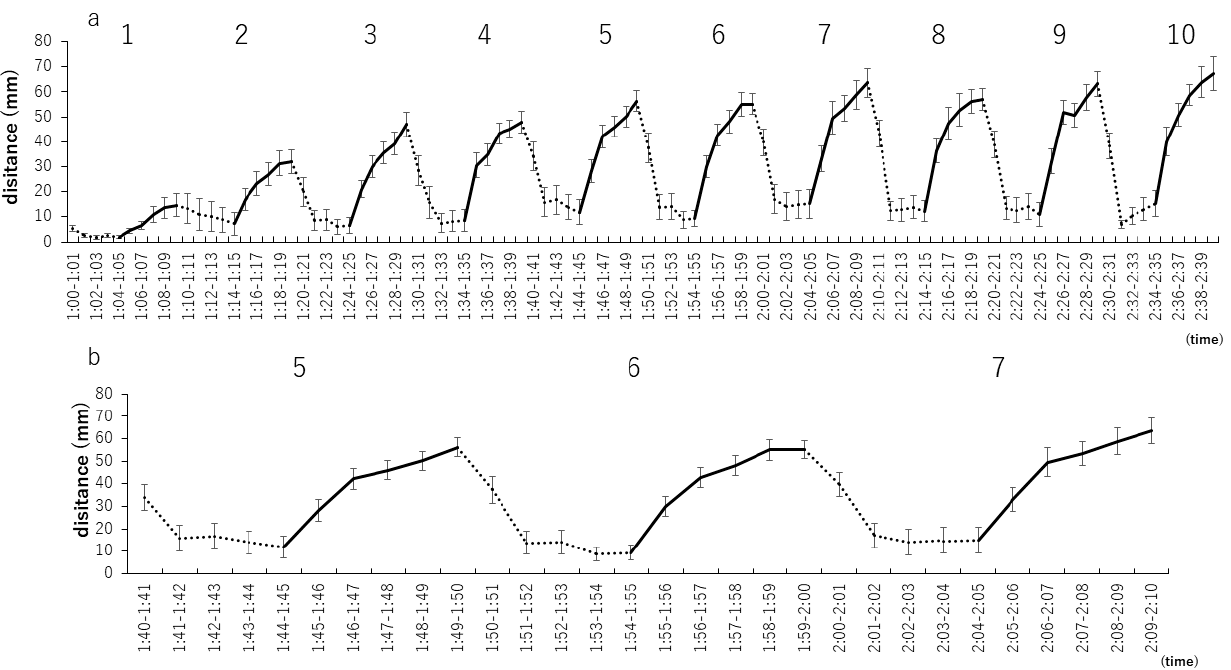
Figure 4. Distance traveled by zebrafish larvae in 1 min with specific numbers of repetitions of light–dark stimuli at 5-min intervals. ( a ) Distances traveled by zebrafish larvae from the first to the 10th repetitions were analyzed every minute for a more detailed assessment of this variable. ( b ) Analysis of stable 5th to 7th distance traveled.